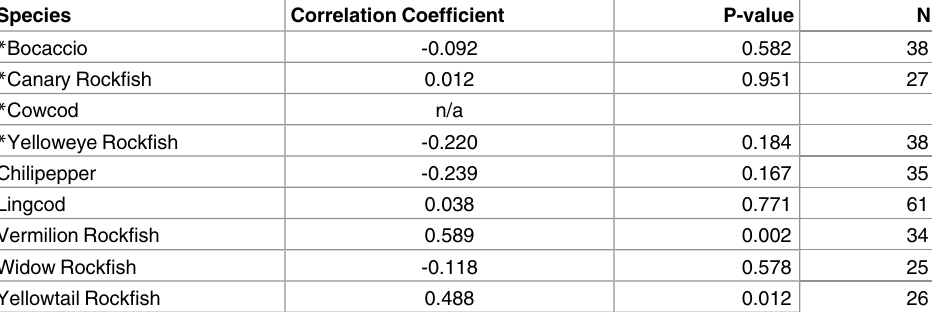
Odds-ratio ( S2 Table) and risk-ratio (Table 7) analyses indicated that four species were more likely to be caught with commercial gear in areas where they were observed on camera. Yellowtail Rockfish exhibited the greatest increase in probability (risk-ratio = 62.48) of being captured when this species was observed on video in the same area. Yellowtail Rockfish was caught almost exclusively in areas where it was also observed on video surveys and was not caught in fishing sets in areas in which it was absent from the video surveys (Table 7). Canary Rockfish (risk-ratio = 24.23), Vermilion Rockfish (risk-ratio = 7.29), and Bocaccio (risk- ratio = 3.64) were all more likely to be caught if observed on video in an area. Conversely, Chi- lipepper, Cowcod, Lingcod, Widow Rockfish, and Yelloweye Rockfish did not have odds or risk-ratios significantly different than 1, indicating that the probability of catching these spe- cies with fishing gear did not change when these species were recorded from video surveys in the same area. Table 6. Correlation between the number of fish caught in experimental fishing sets and the number of fish observed in video surveysfor target and rebuilding species. N represents the number of sample units in which a species was caught or observed.